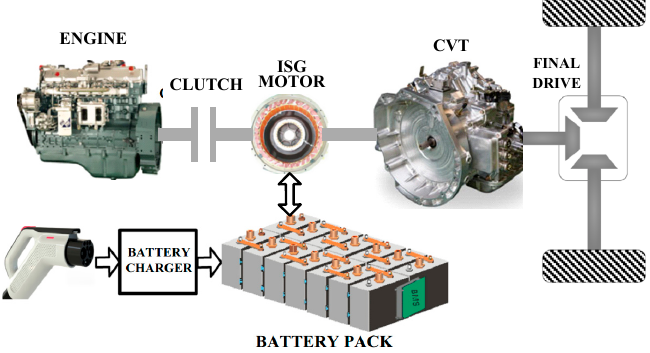
Figure 1. Parallel continuously variable transmission (CVT)-based plug-in hybrid electric vehicle (PHEV) powertrain system. Table 1. Basic parameters of the PHEV.